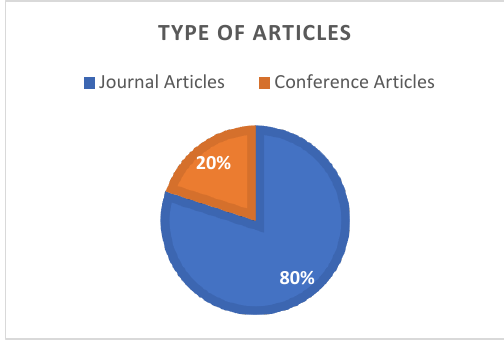
Figure 4. Interest over time for the keyword “IoT”.